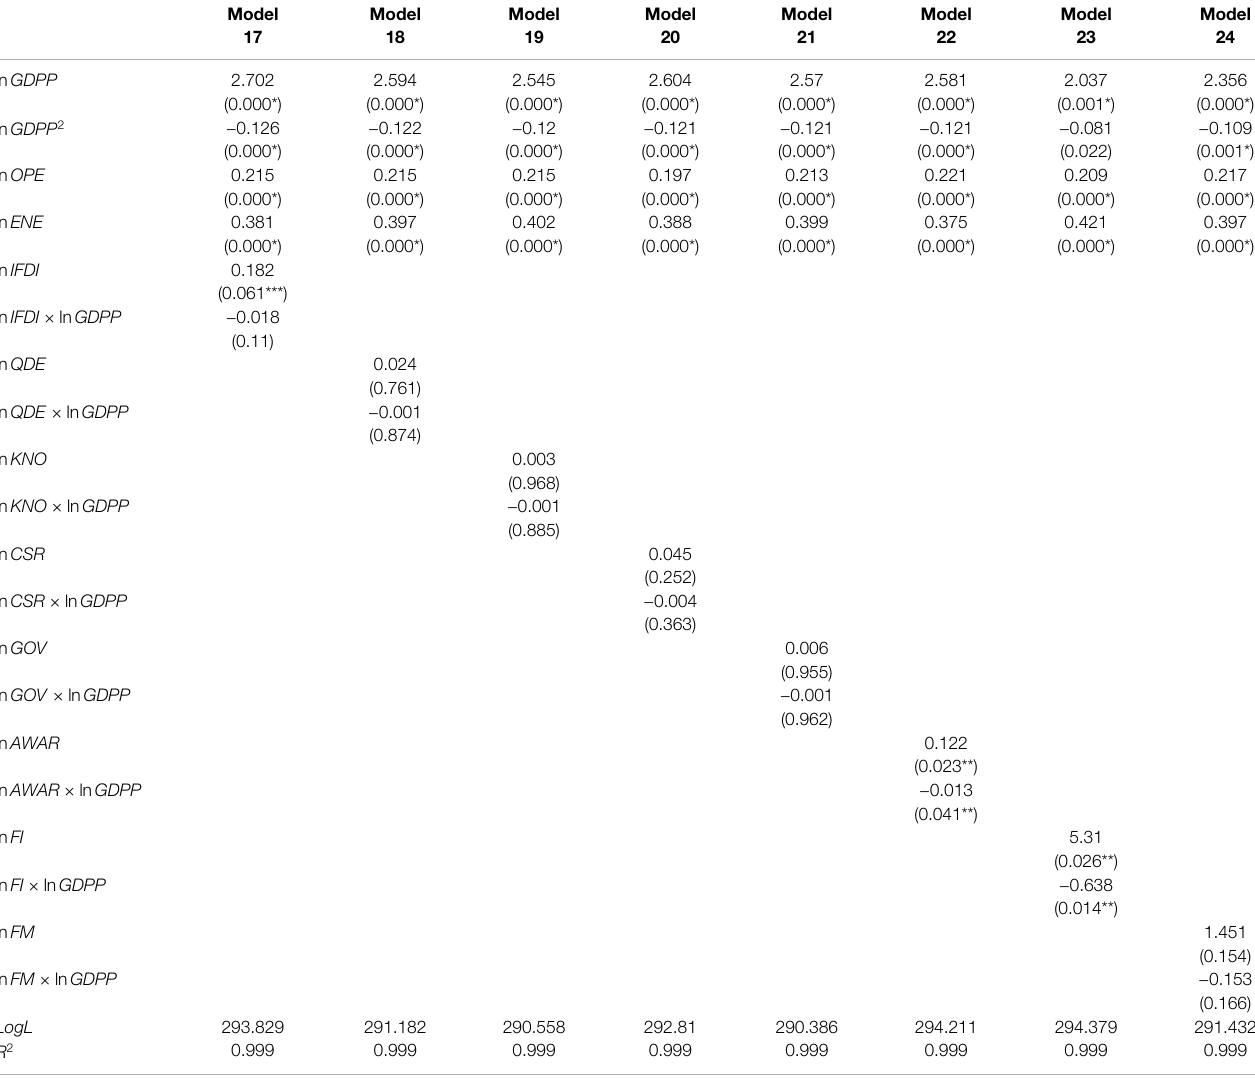
TABLE 8 | Estimation results of different models for Eq. 6